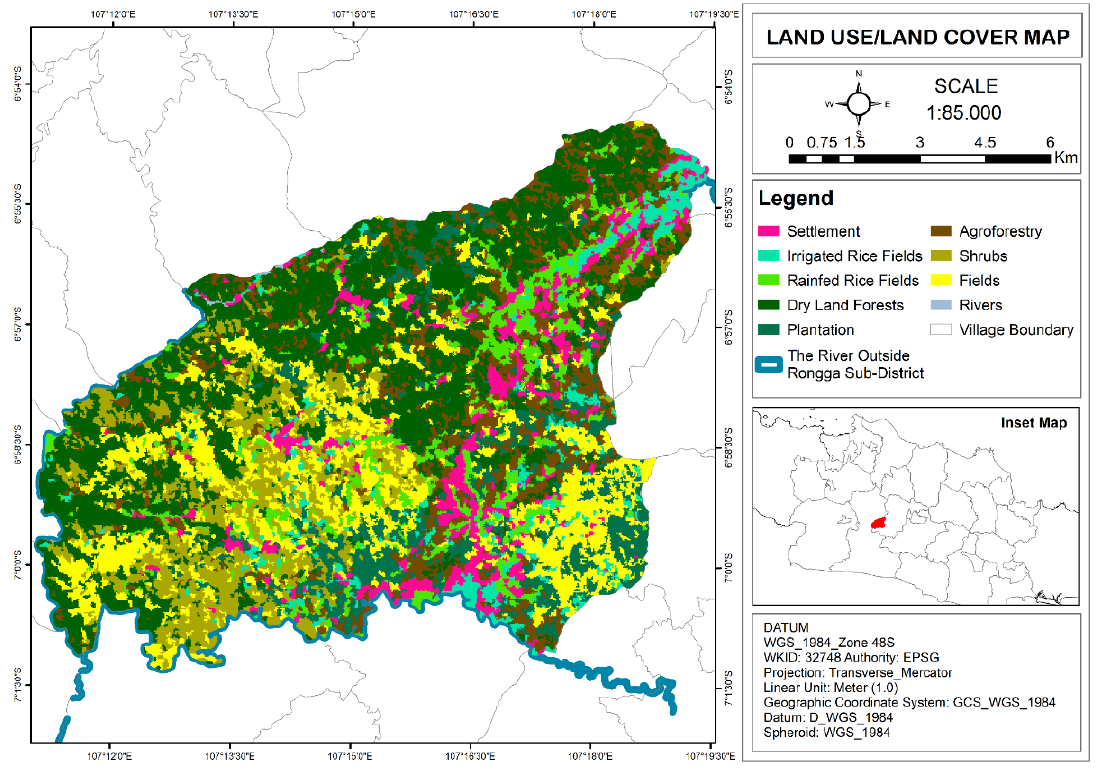
Figure 3. Land use/land cover of Rongga